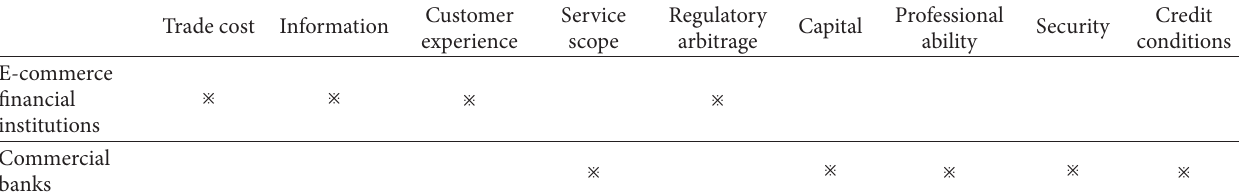
Table 1: Comparative advantages between e-commerce financial institutions and commercial banks.